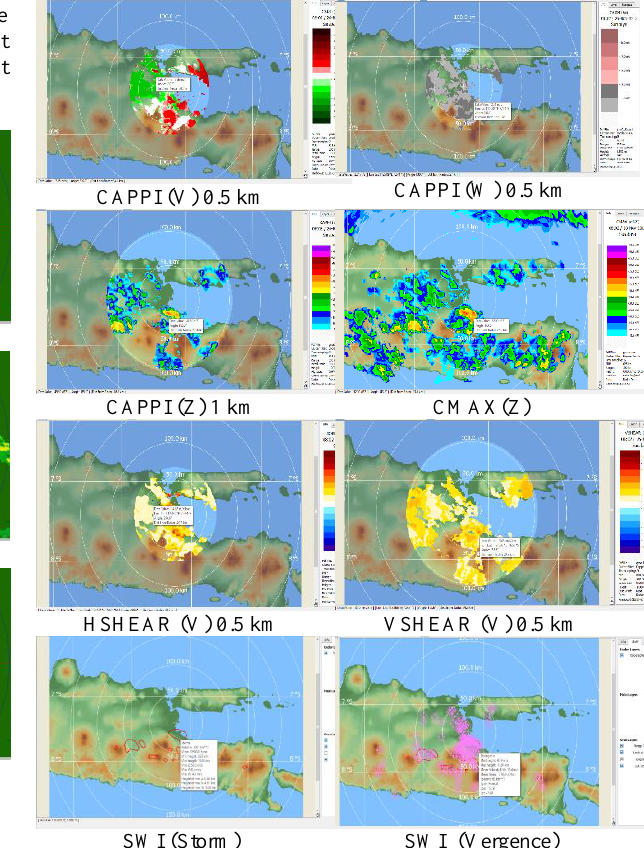
Figure 3. The observation of the weather radar does not show the existence of convective clouds on the location and time specified by BNPB.